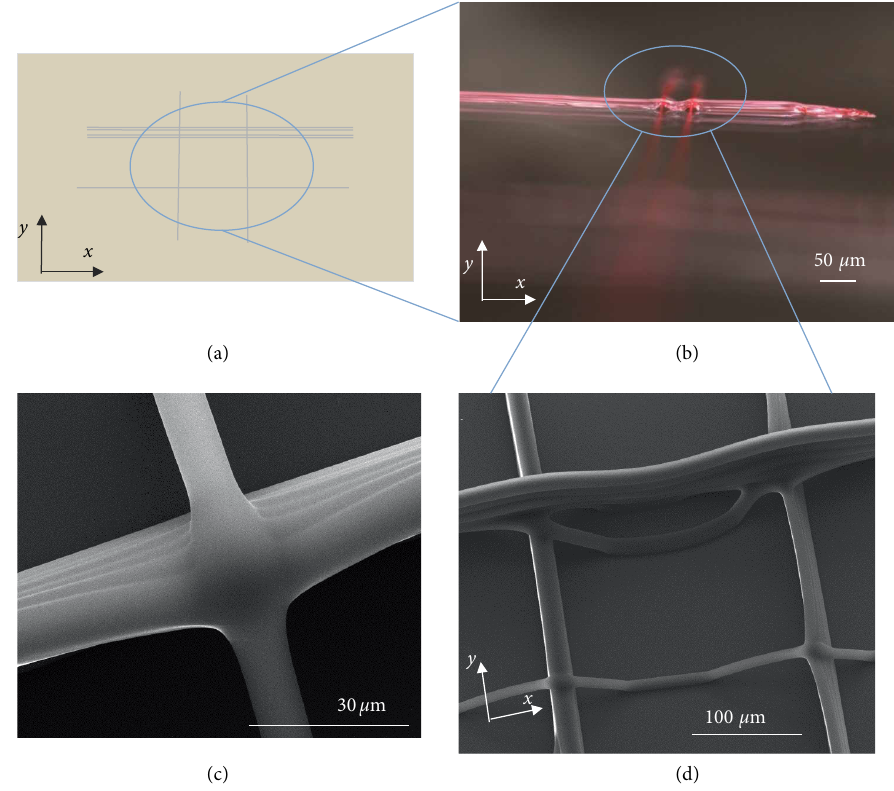
Figure 4: (a) Schematic outline of the experiment. (b) Streomicroscope image of a single wall crossing a matrix of single fibers at the bottom. (c) Close up of the crossing and focus on a crossing point making evident the good control in superimposition (d).